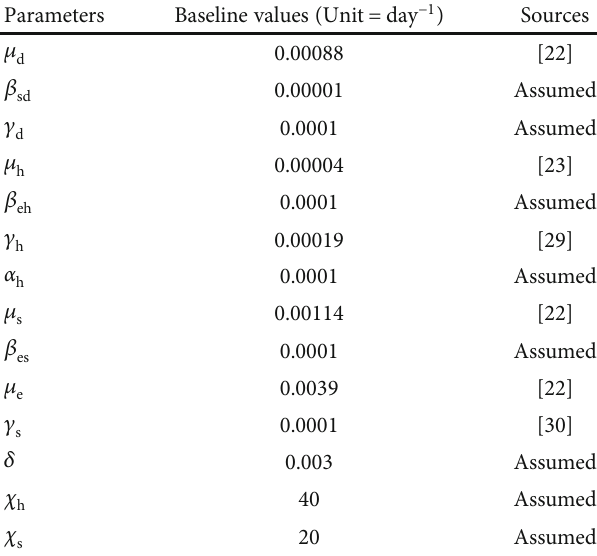
Table 3: Parameters, baseline values, and sources.